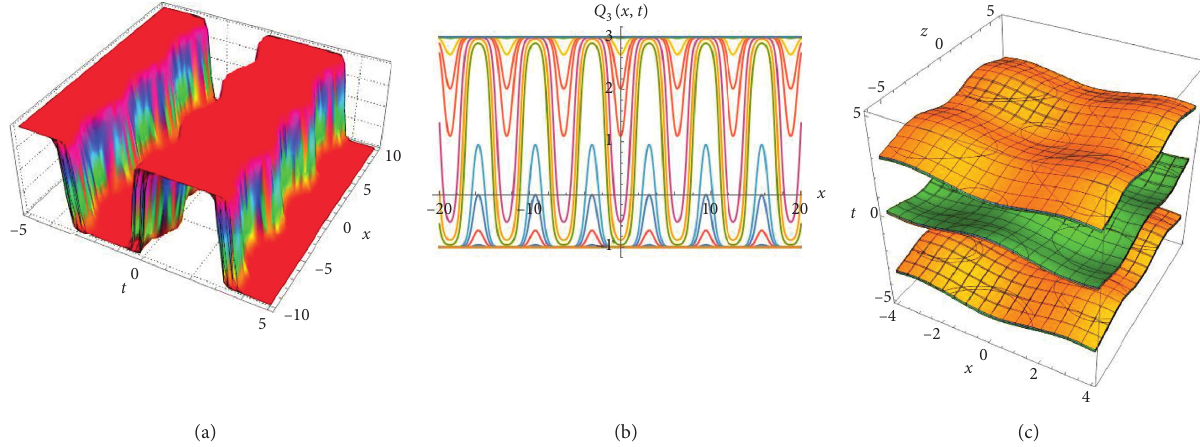
Figure 2: Kink solitary wave solutions of equation (21) in three-dimensional, two-dimensional and contour plot 3D for � 1 , α � − 1 , μ � 4 , and ϑ � a 0